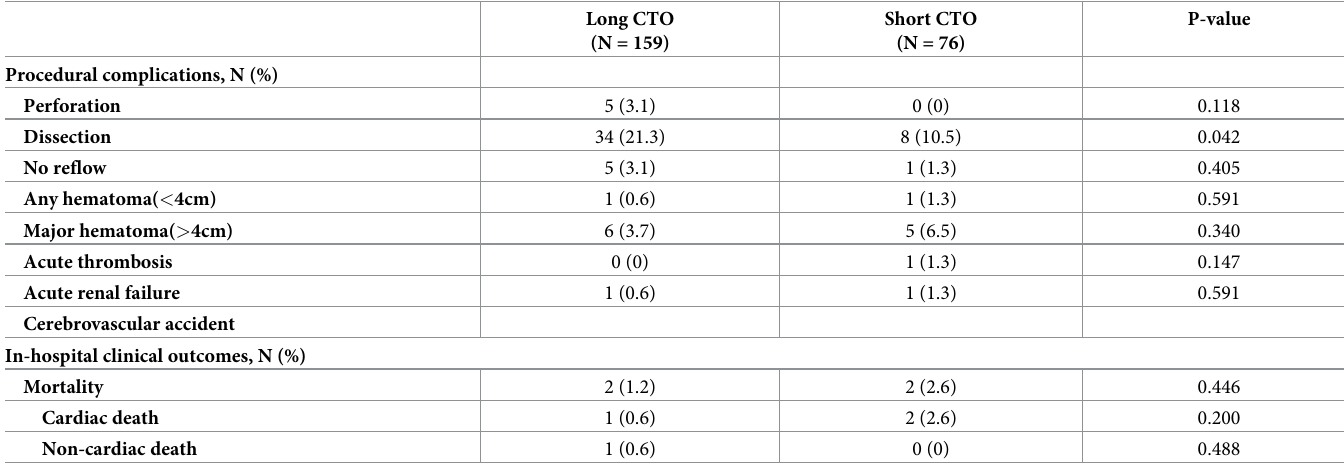
Table 2. Procedural complications and in-hospital clinical